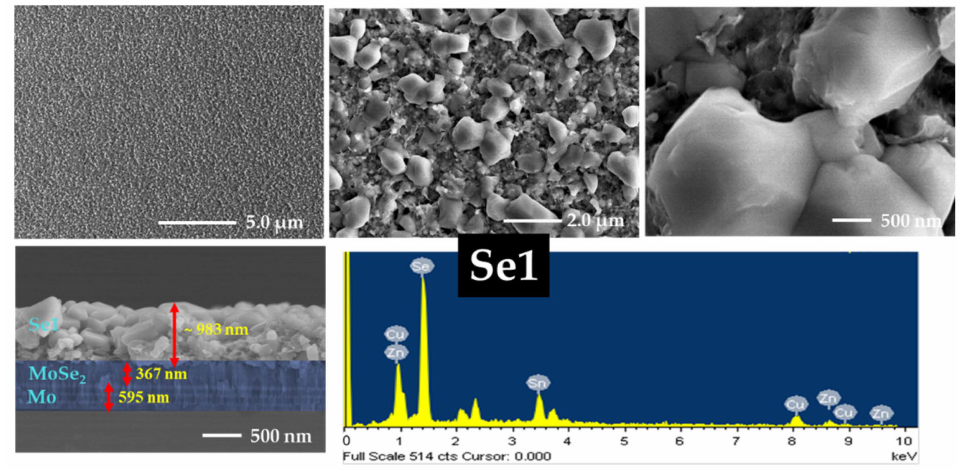
Figure 5. Surface and cross-section images and EDS spectra of Se1 thin film.